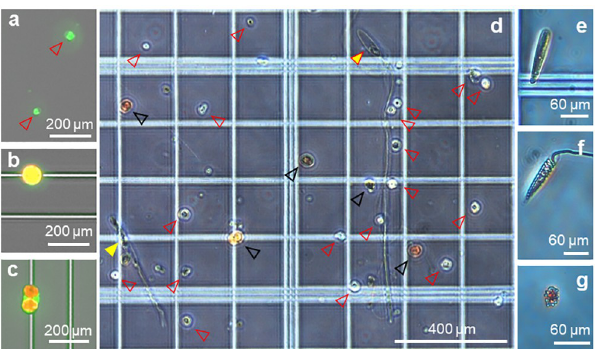
Fig 8. Coral cell variety (microscope photographs). Different cell types observed after dissociation from P . acuta nubbbins, coral host cells of different sizes (a, red arrow heads), single Symbiodinaceae cell (b), two symbiotic cells encapsulated inside a coral host cell (c). (d) unsorted cells composed of miscellaneous coral host cells (red arrow heads), symbiotic Symbiodinaceae (black arrow heads), deployed trichous haploneme nematocyst (yellow arrow head) and deployed mastigophore nematocyst (yellow arrow head with red outline), closed capsule of trichous haploneme nematocyst (e), spirocyst nematocyst (f) and amoebocyte-like cell (g). Photographs (a)–(c) were taken using a Cytation3 imaging plate reader with GFP and Texas Red filters. Photographs (d–g) were taken under a compound microscope (no staining).